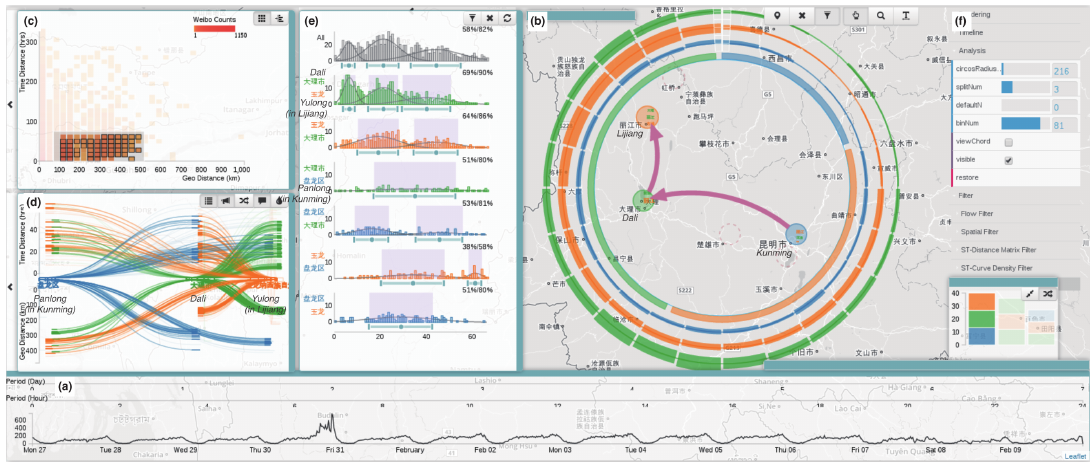
Figure 11. A visual analytics system for exploring sparse microblogging data. Several visualization techniques are interrelated [14] (extracted from